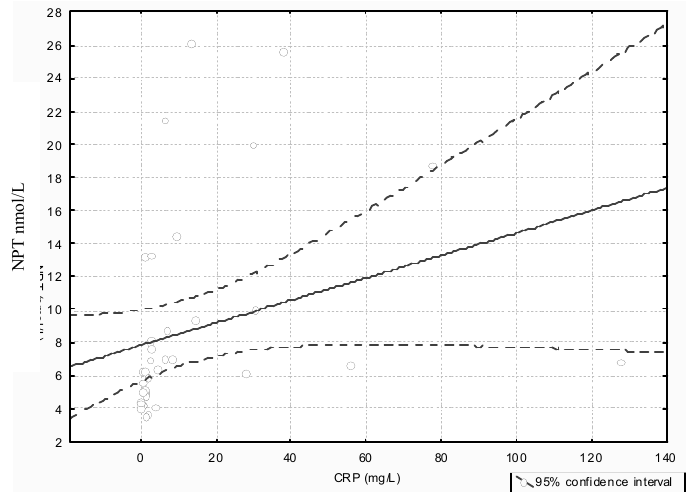
Figure 2. Correlation between serum neopterin and CRP